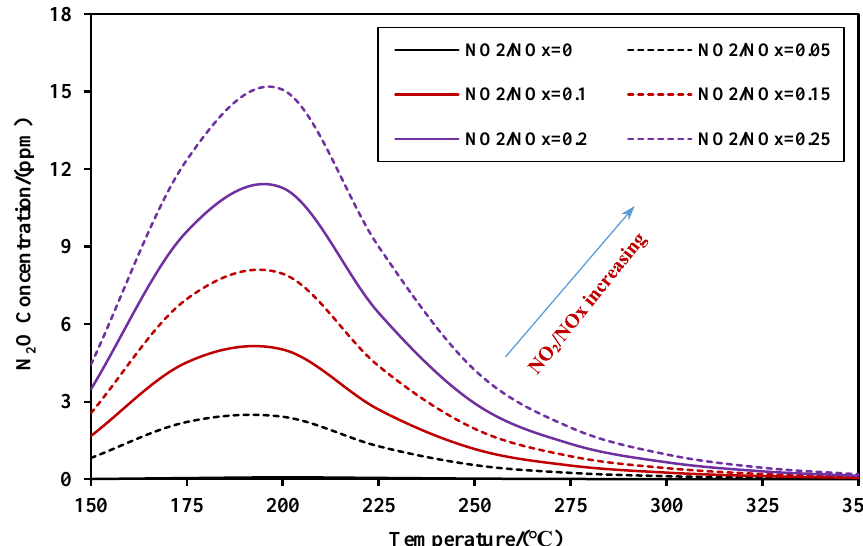
Figure 3. The influence of the reaction temperature and the NO 2 /NO x ratio on the formation of N 2 O.